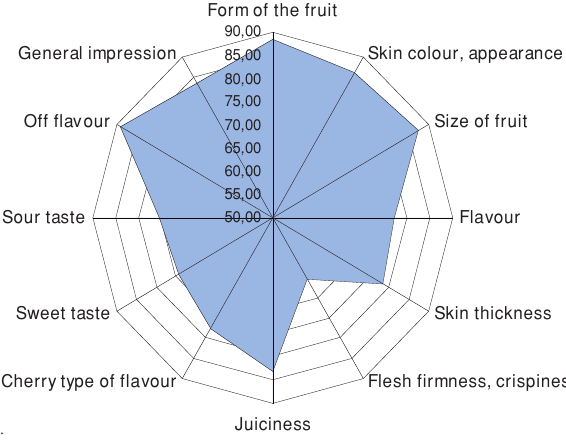
Figure 3. Profile diagram of the sensorial judgement of the variety Bigarreau